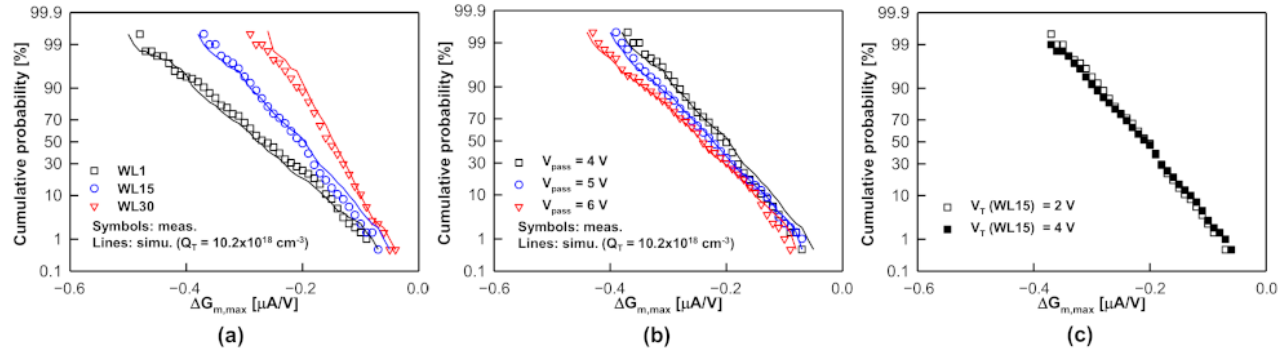
Figure 10. ∆ G m , max distributions for ( a ) different selected WLs in the string. All cells in the string with V pass = 6 V , ( b ) WL15 selected with different values of V pass , and ( c ) WL15 selected with different V T levels. Except for the read cells, the others are in the erased state. Reprinted from